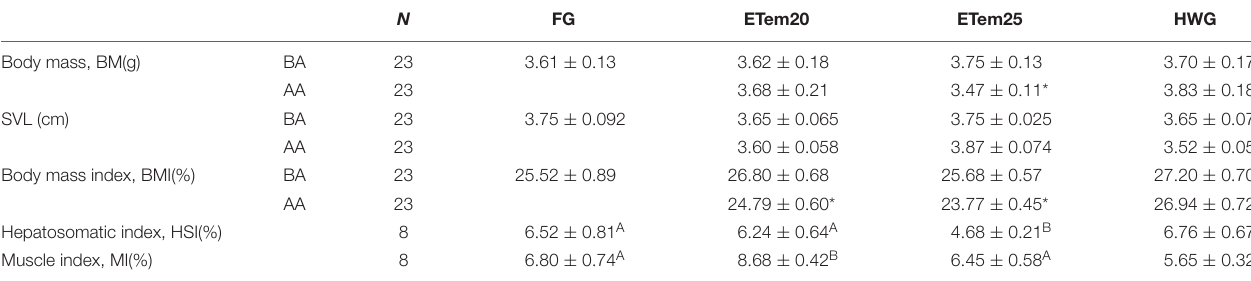
TABLE 1 | Morphological comparison of Nanorana pleskei in different temperature acclimation groups and field group. N FG ETem20